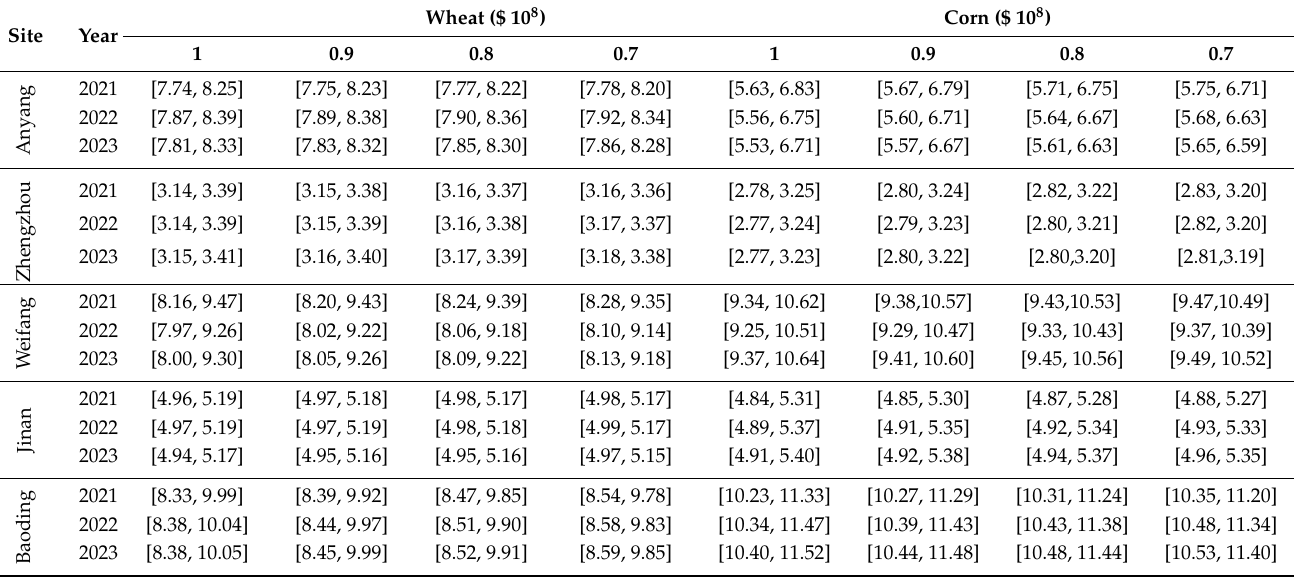
Table 10. Interval parameters of production value of winter wheat and summer maize in five cities under different possibility